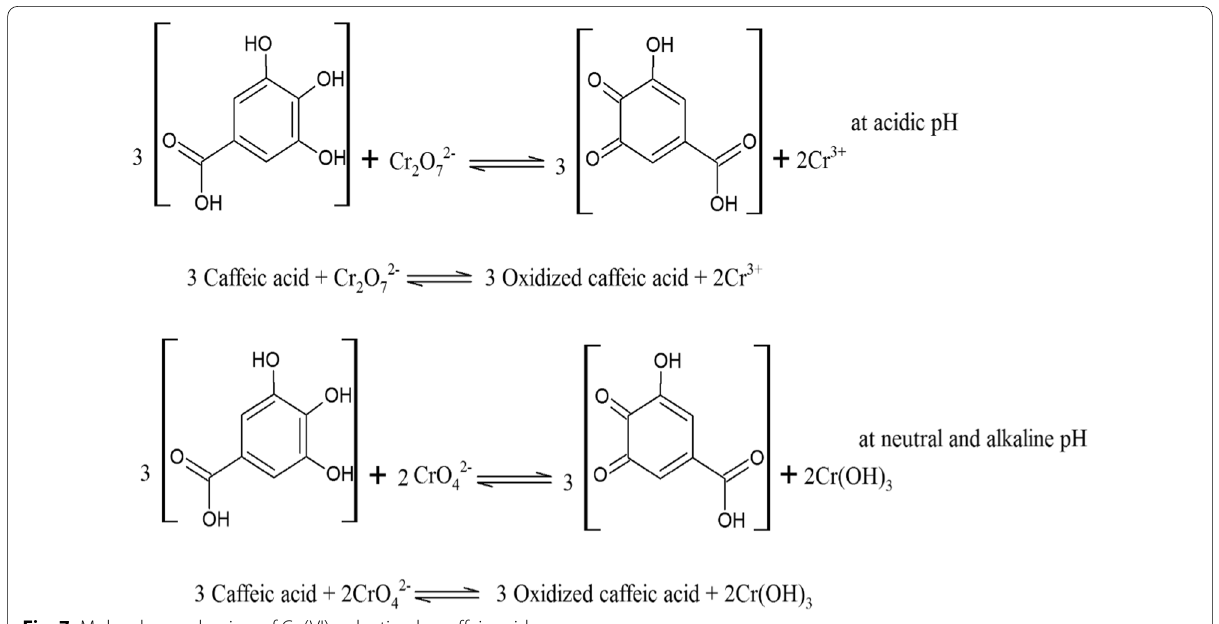
Fig. 7 Molecular mechanism of Cr (VI) reduction by caffeic